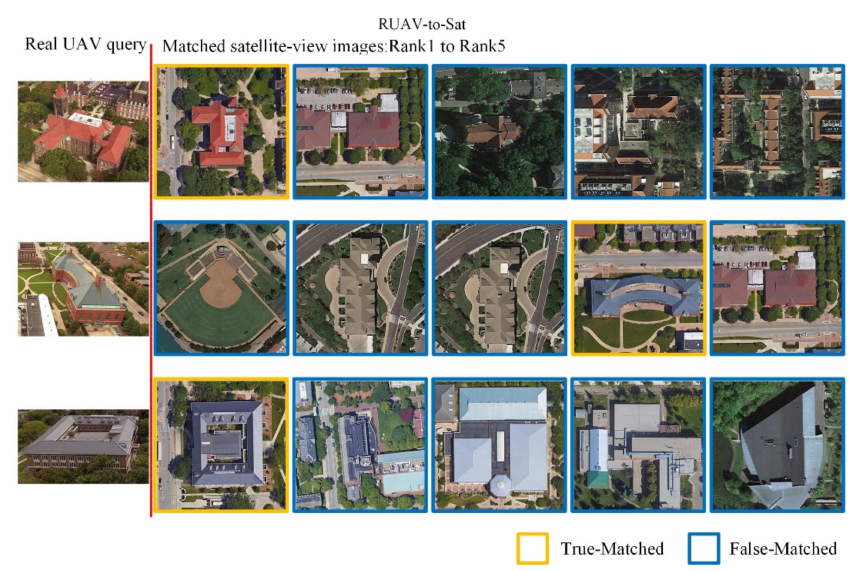
Figure 11. The matching results for RUAV-to-Sat (the real UAV-view image as a query to match the satellite-view